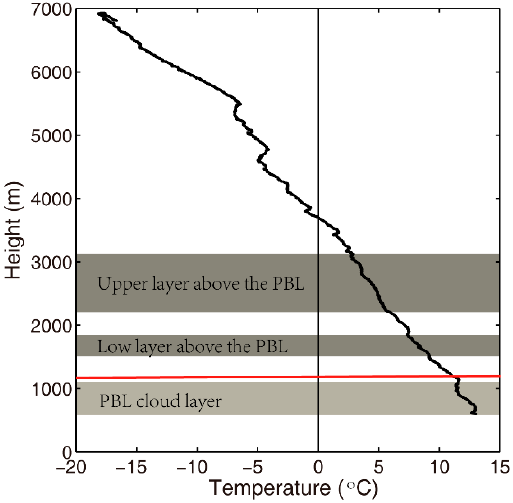
Figure 2. Profile of temperature observed by the aircraft between 600 m and 6900 m over Huanghua, China on 26 April 2014. The height ranges with filled gray colors are the height ranges with observed cloud layers. The black and red lines represent the 0 ° C and PBL height, respectively.